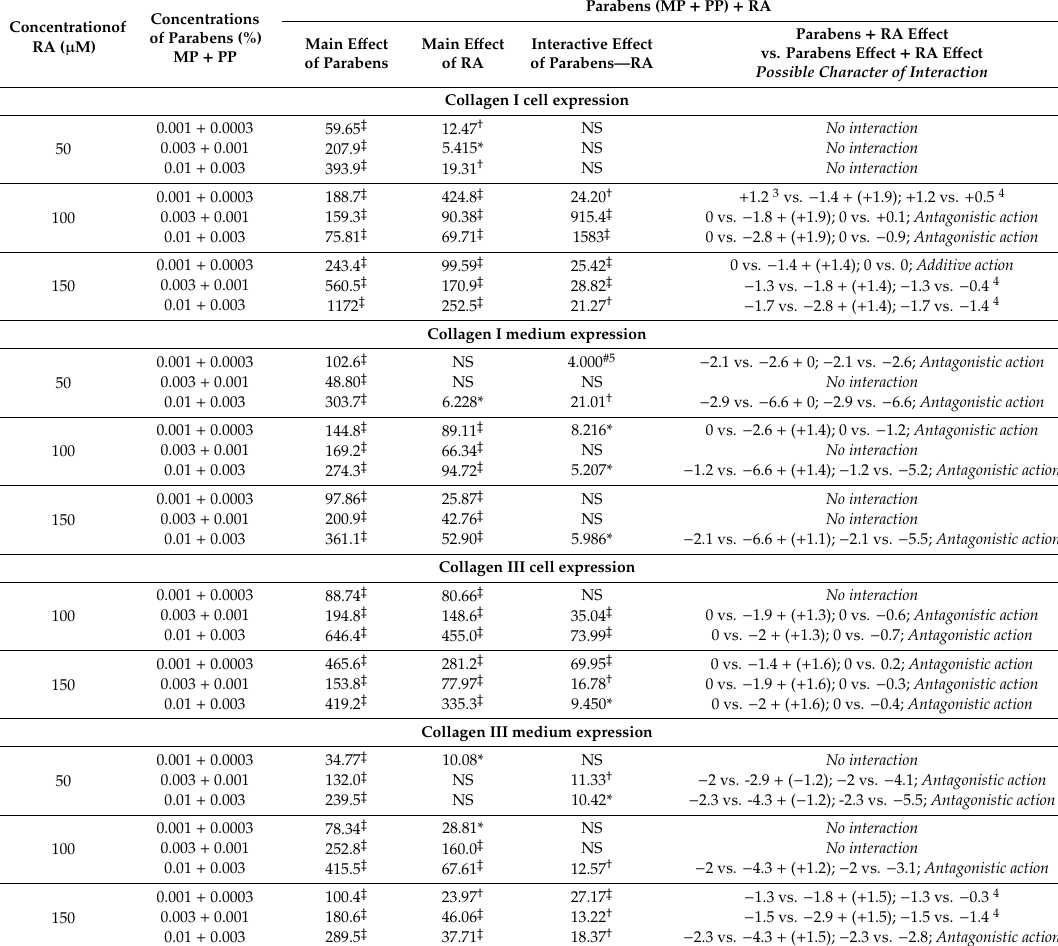
Table 2. Estimation of the main and interactive e ff ects of parabens (methylparaben—MP and propylparaben—PP) and rosmarinic acid (RA) on the expression of intracellular (cell) and extracellular (medium) collagen I and III in the human skin fibroblasts 1, 2